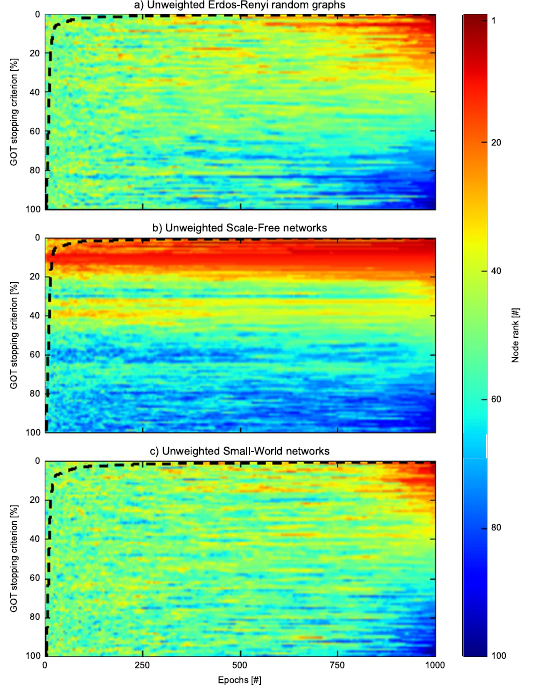
Figure 2. GOT visualization. Nodes rank assigned by GOT in each epoch, while it runs for 1000 epochs in random generated networks with 100 nodes and between 500 and 1000 links. The results are averaged on 10 different networks for each network type. The dash lines show GOT stopping criteria as a percentage of the total number of nodes, at any epoch